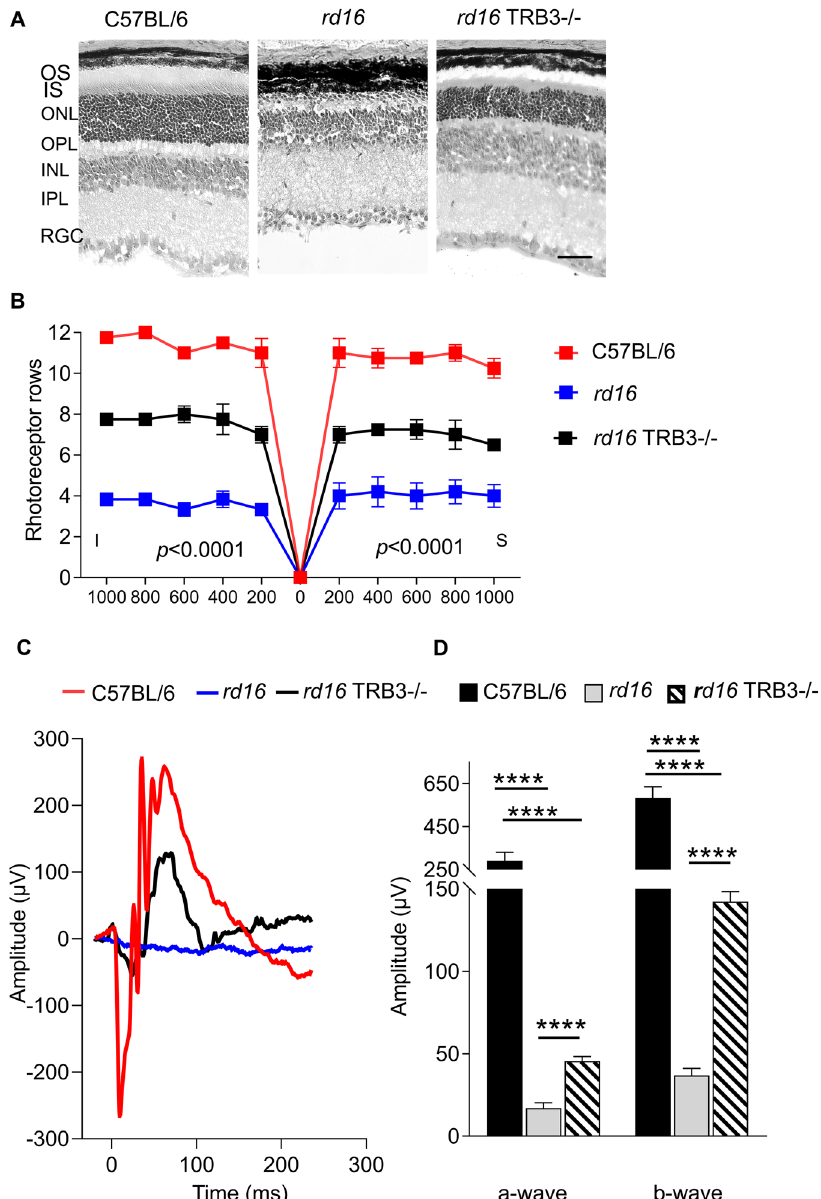
Fig. 3 TRB3 knockout decreases the photoreceptor cell loss detected in P18 rd16 retinas. A Images of C57BL/6, rd16 , and rd16 TRB3 − / − retinas stained with eosin and hematoxylin are shown. The scale is 50 µm. B The retinal images were used to calculate the photoreceptor nuclei across the retinas. Preservation of photoreceptor cells was detected in rd16 TRB3 − / − mice compared to rd16 mice ( n = 4 – 5). This preservation was in accordance with the improvement of a- and b-scotopic ERG amplitudes registered at P18 ( n = 3 – 7). C Images of the scotopic ERG traces. D ERG analysis demonstrated a statistically signi fi cant increase in the a- and b-wave amplitudes in rd16 TRB3 − / − retinas. Data are shown as mean ± SEM; **** p < 0.0001. OS outer segments of photoreceptors, IS inner segments of photoreceptors, ONL outer nuclear layer, OPL outer plexiform layer, INL inner nuclear layer, IPL inner plexiform layer, RGC layer retinal ganglion cell